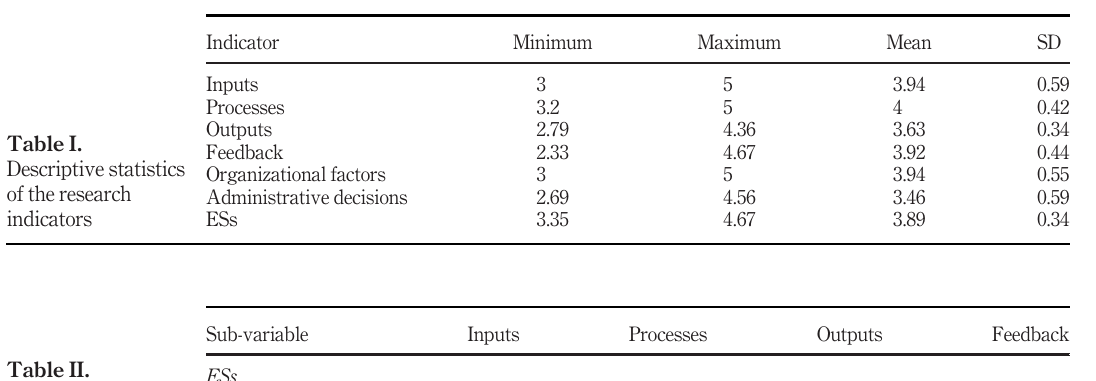
Table II. Pearson coef fi cient of ESs sub-variables